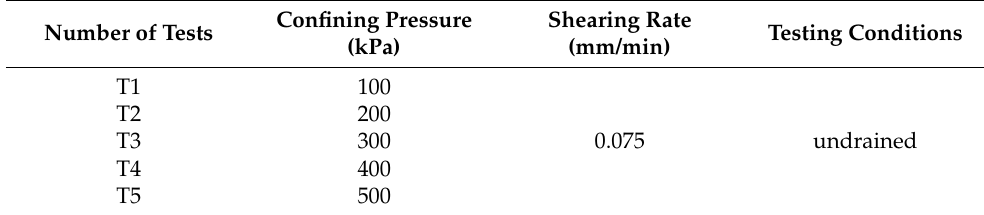
Table 3. Test program.